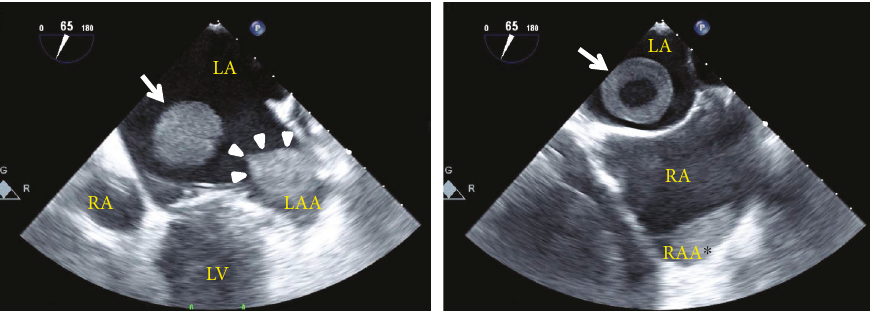
Figure 2: Two-dimensional transesophageal echocardiographic images of the free- fl oating ball-shaped mass (arrows), left (arrow heads), and right ( ∗ ) atrial appendage thrombi. LA: left atrium; LAA: left atrial appendage; LV: left ventricle; RA: right atrium; RAA: right atrial